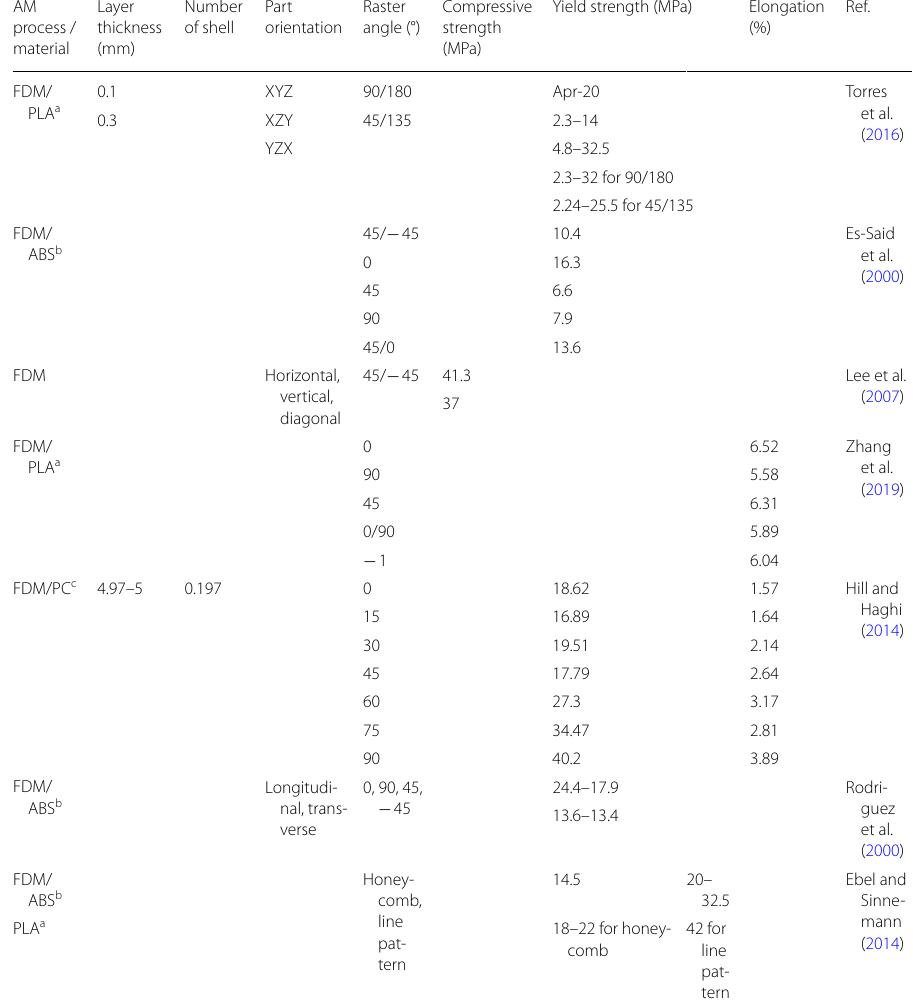
Table 9 Influential FDM process parameters on compressive and yield strengths and elongation at